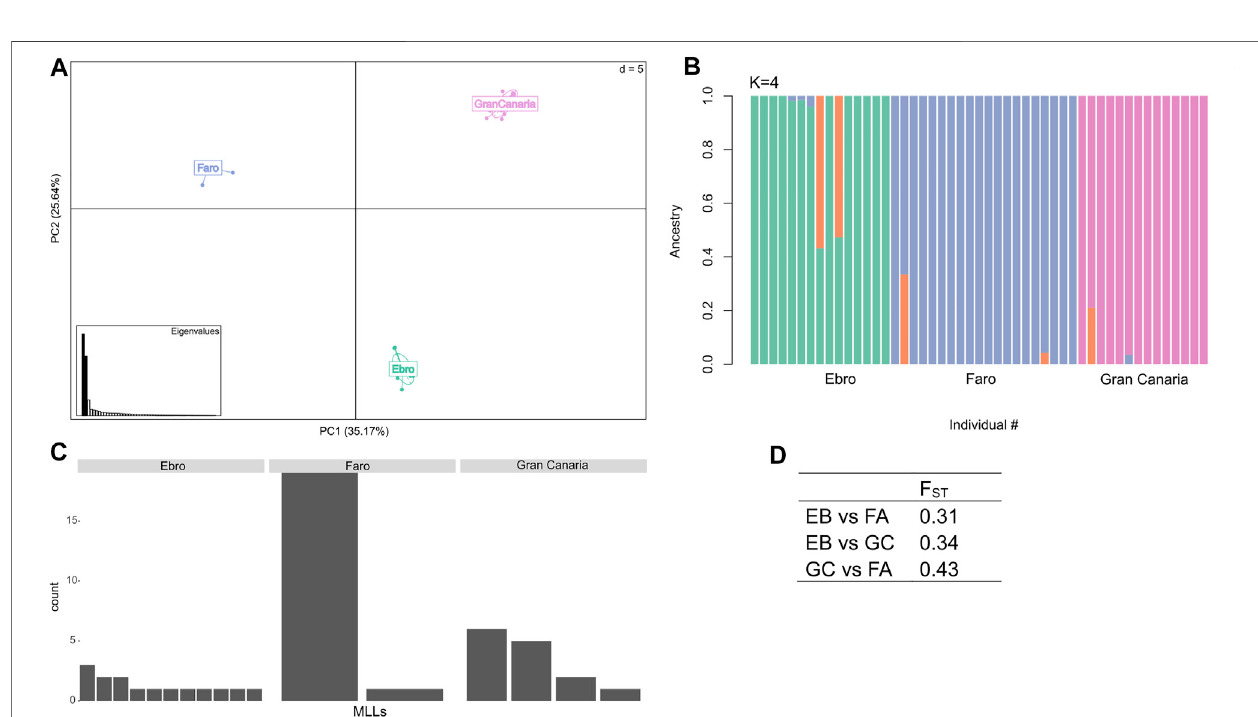
FIGURE3| Populationstructureanalysisandclonaldiversity. (A) PrincipalComponentAnalysis(PCA)displayingthethree C.nodosa populationscollectedalonga latitudinal gradient of distribution (i.e., Gran Canaria, Faro and Ebro). (B) Admixture plot of the C. nodosa populations at K = 4. (C) Number of distinct Multi Locus Lineages (MLLs) identi fi ed at each sampling site. (D) Weir and Cockerham F ST weighted estimate between populations.